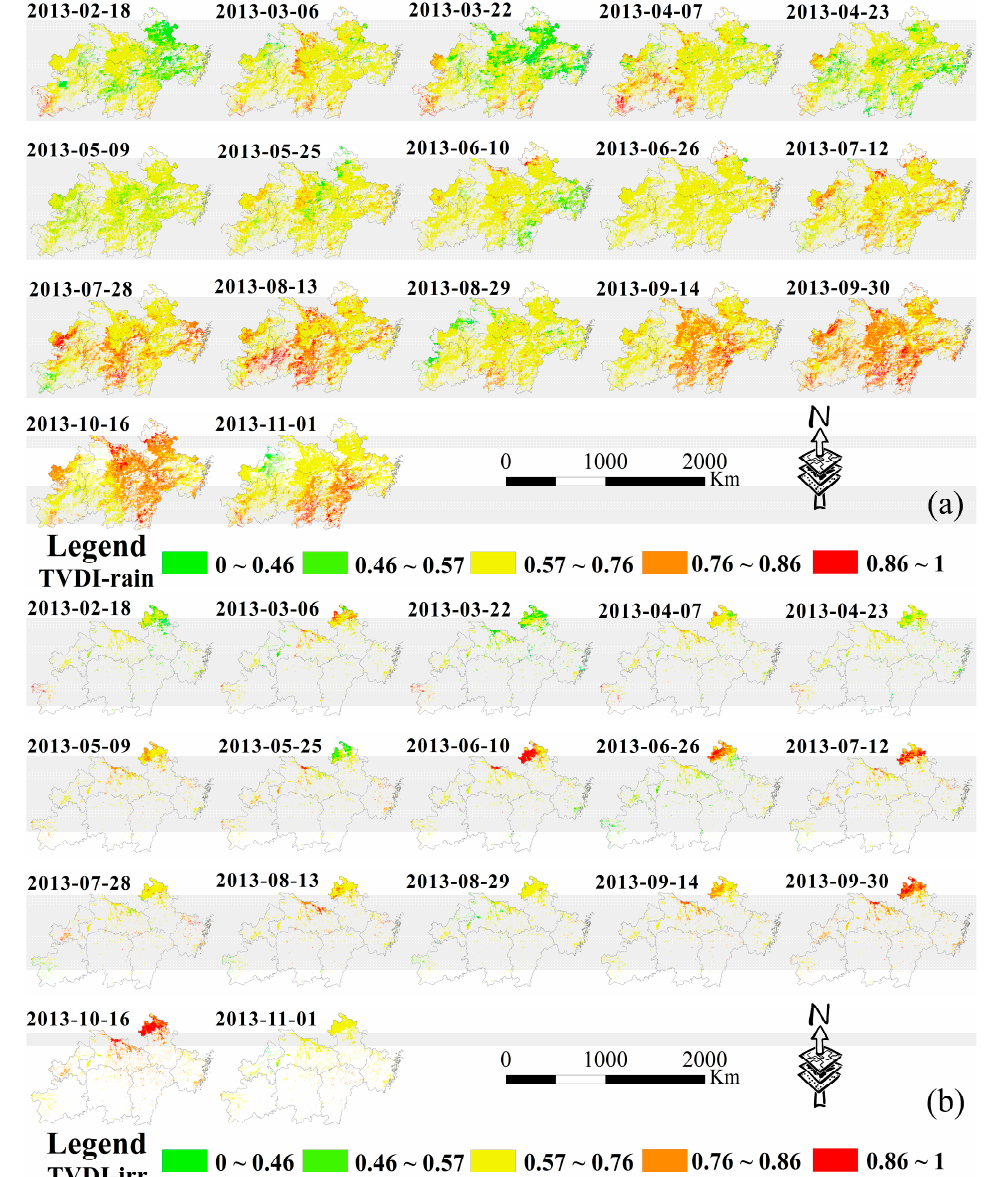
Figure 11. Spatial distribution of the Temperature Vegetation Drought Index (TVDI) in the middle and lower reaches of the Yangtze River in China in 2013, with a temporal resolution of 16 days. The images without crop growth in January and December were removed. ( a ) The TVDI of rain-fed arable land (TVDI-rain). ( b ) The TVDI of irrigated arable land (TVDI-irr).